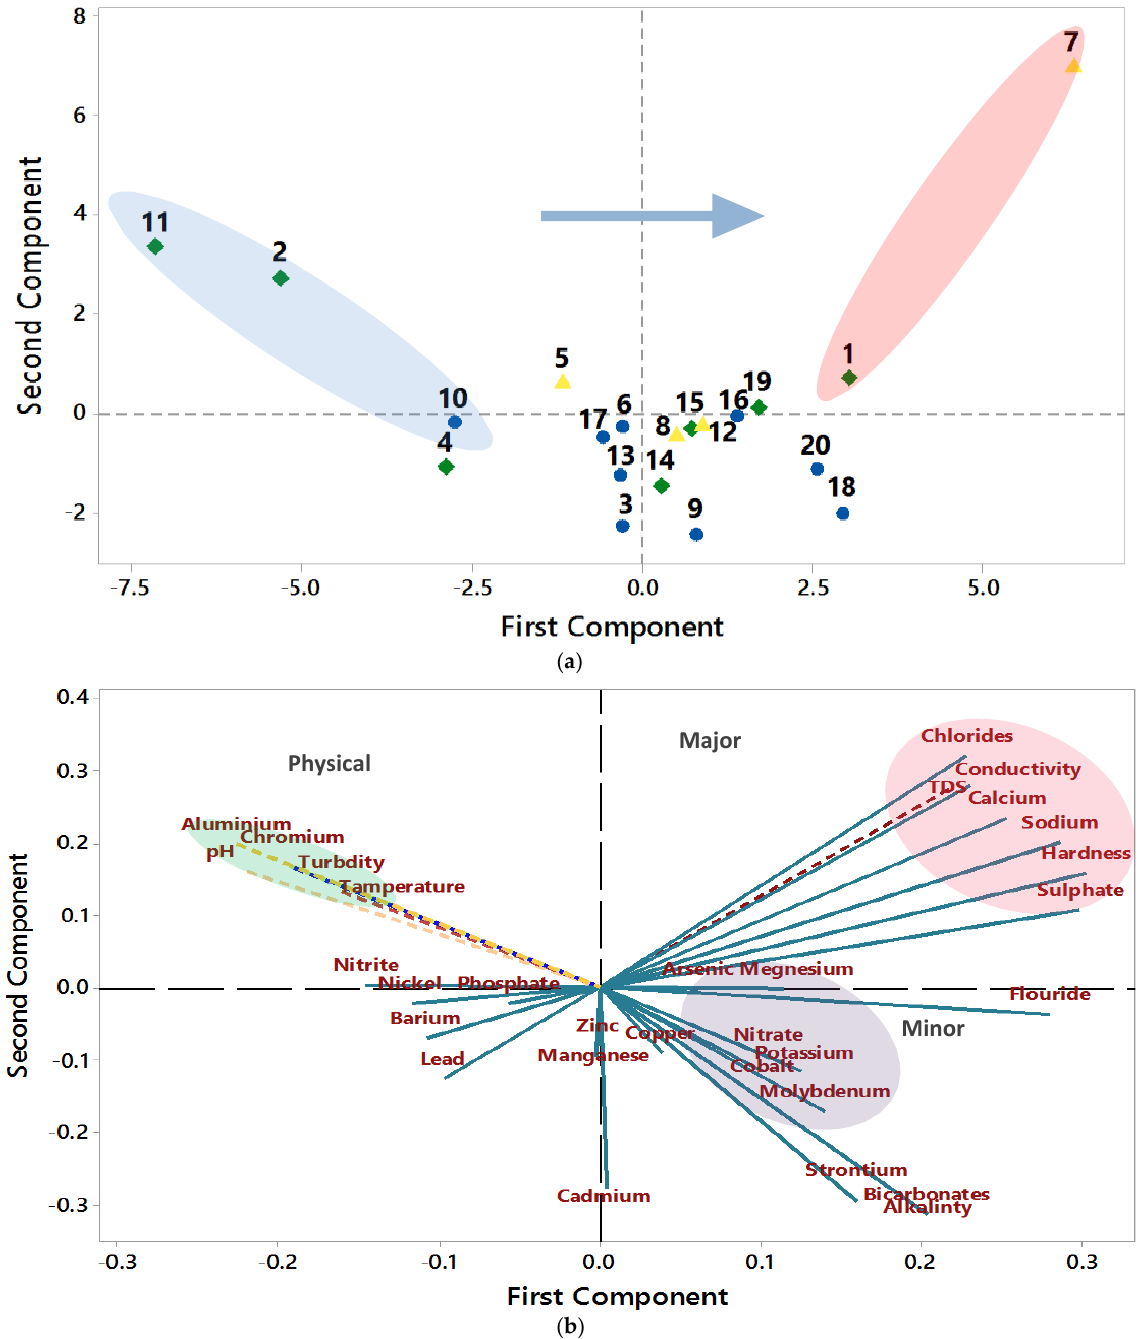
Figure 5. PCA graphs ( a , b ) show negative and positive trends of samples and parameters. In graph ( a ) public places are denoted by a yellow color, agriculture by a green color, and residential areas by a blue color. Shaded circular regions in various colors in the plots indicate the main clusters of measured variables concentration changes and the sampling locations which are based on the land use and anthropogenic activities in the study area.